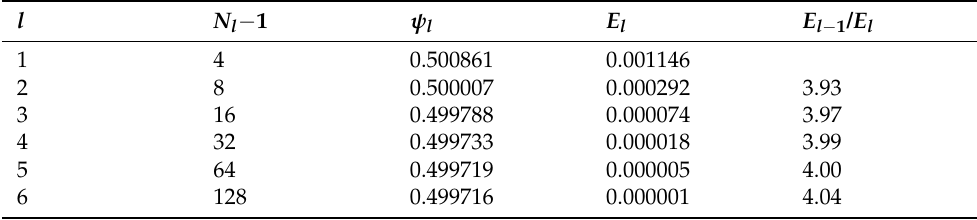
Table 1. Approximation ψ l of the temperature in the tank at time τ = 1 and the corresponding error E l for different numbers of space mesh points N l .